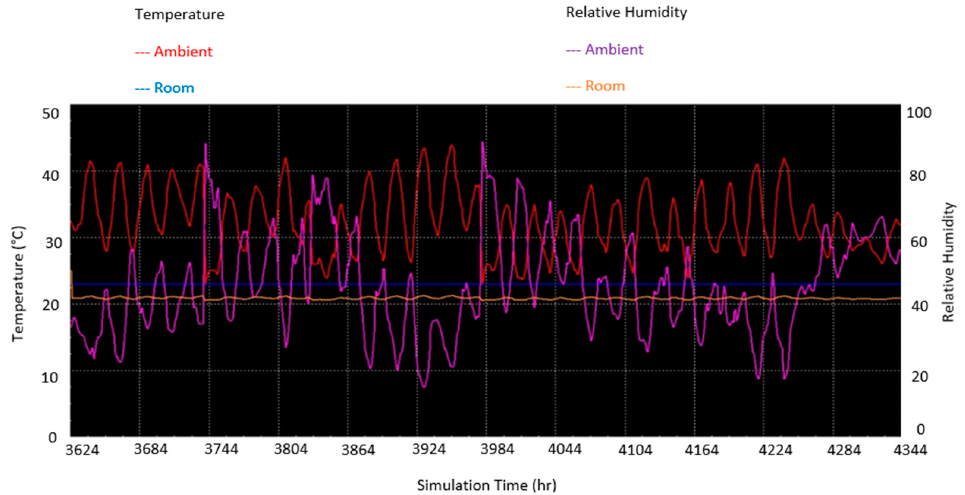
Figure 17. June simulation run for option B.